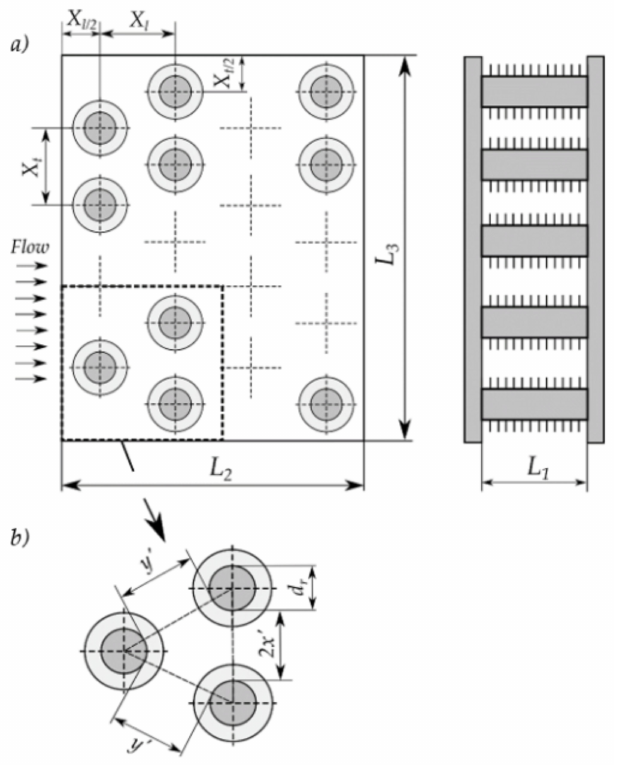
Figure 1. Finned heat exchanger tube arrangement: ( a ) airflow through the heat pipes, ( b ) minimum airflow area (according to [20]).